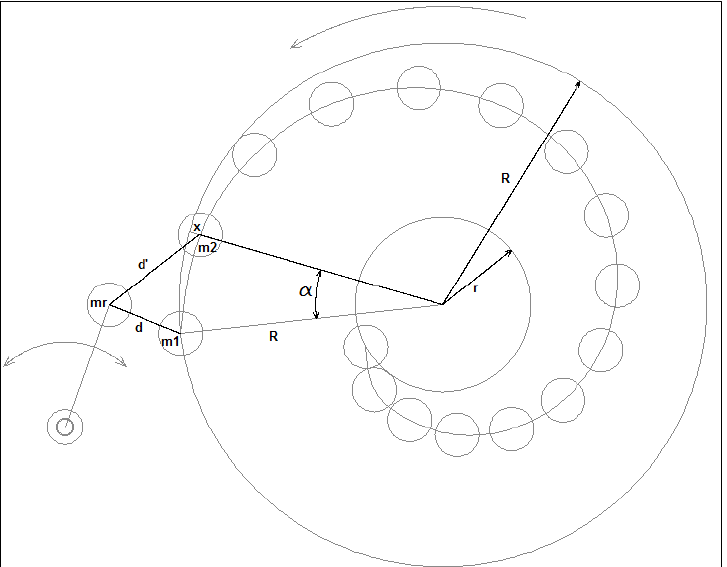
Figure 3. Parameter definition in contactless crank-rocker